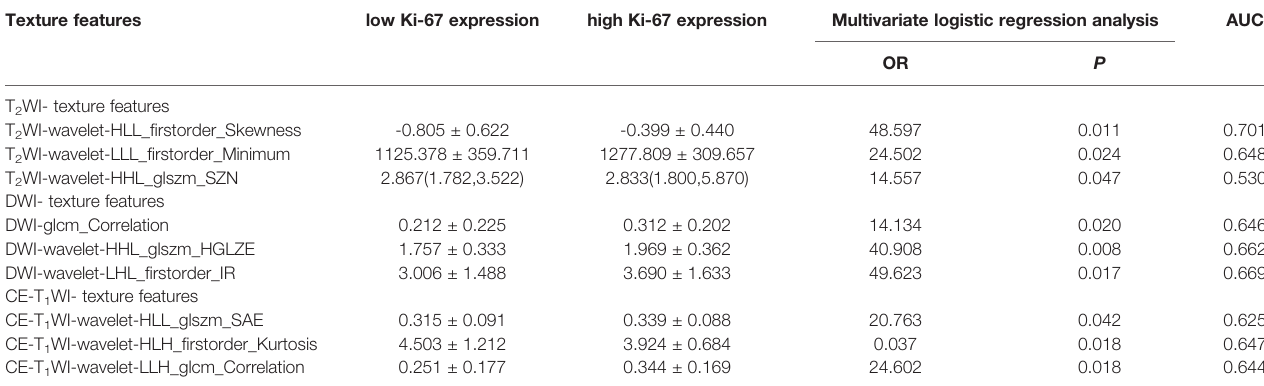
TABLE 3 | Statistical results of texture features of Ki-67 high and low expression groups in EC. Texture